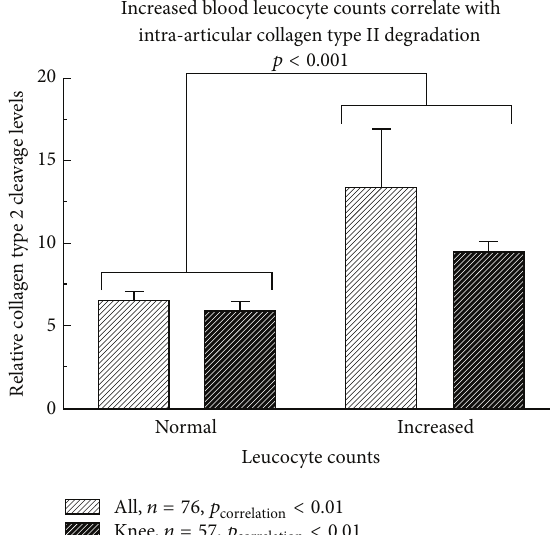
Figure 2: An increasing Kellgren Lawrence Score (KLS), defining progress of osteoarthritis, was associated with enhanced collagen type 2 cleavage levels (C2C), defining cartilage degradation, in septic knee arthritis ( 𝑝 = 0.049 ). The group KLS 3 includes one case with a KLS = 4. Reported are the C2C levels relative to the total protein content.